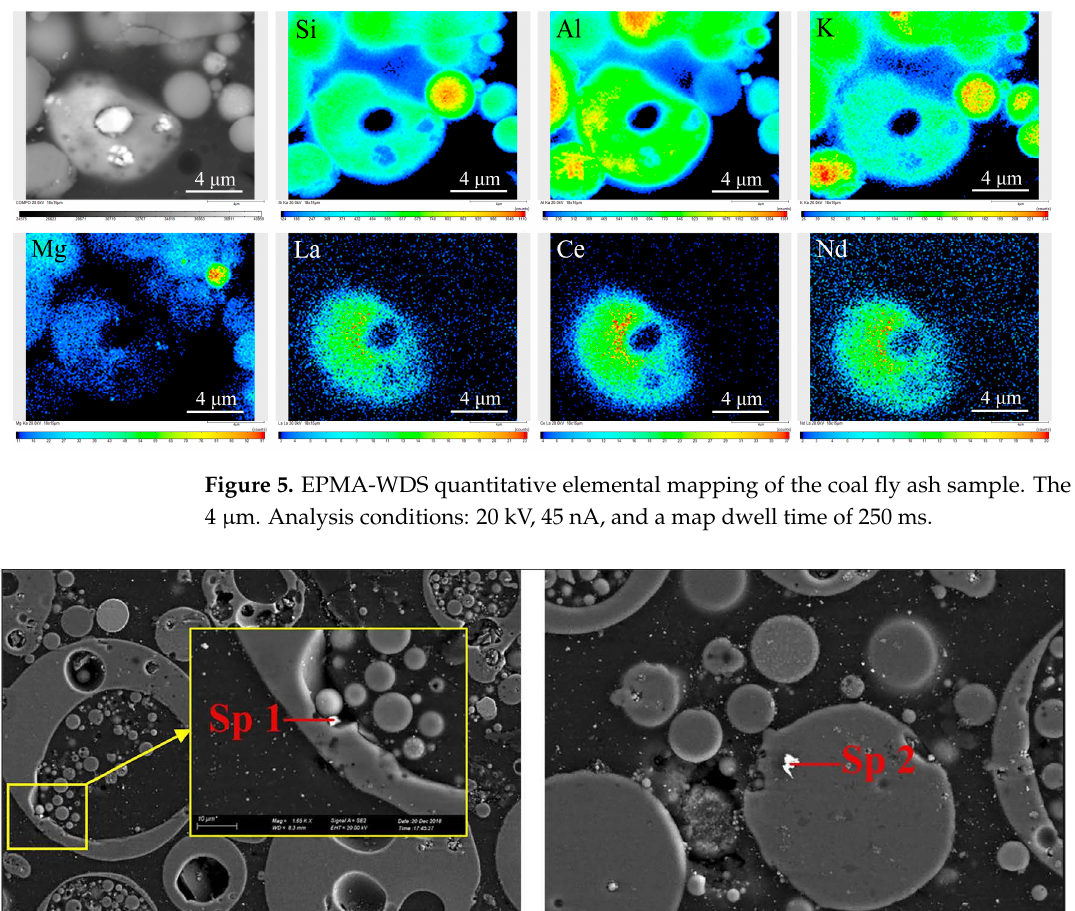
Figure 4. BSE image with element spectra of ( a ) an irregularly elongated-shaped amorphous carrier and ( b ) an irregularly shaped REE mineral—bastnasite.